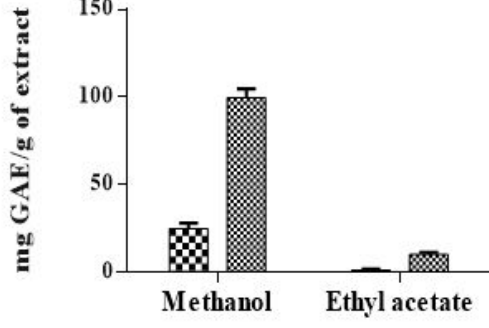
Figure 2: Variation of total polyphenolic content of the extracts of D. falcata